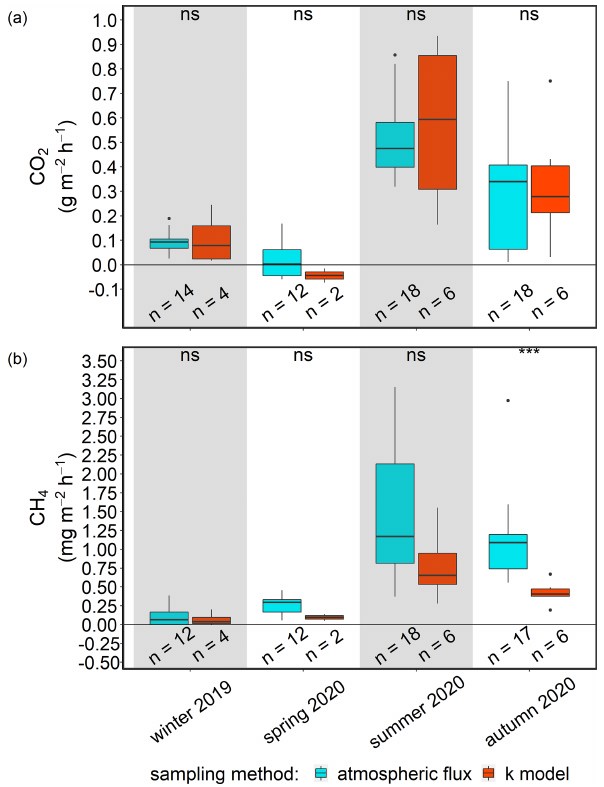
Figure C1. Seasonal post-rewetting fluxes of (a) CO 2 and (b) CH 4 at station BTD7, which is part of the GHG flux transect. Chamber- based atmospheric GHG fluxes are shown in blue and air–sea GHG fluxes from the k model in red. The methodological comparisons within seasons are based on a significance level of p < 0 . 05. ns is for not significant, and the triple asterisks ∗∗∗ mean p < 0 . 001.